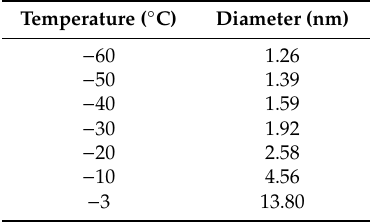
Table 1. Melting temperatures and corresponding pore